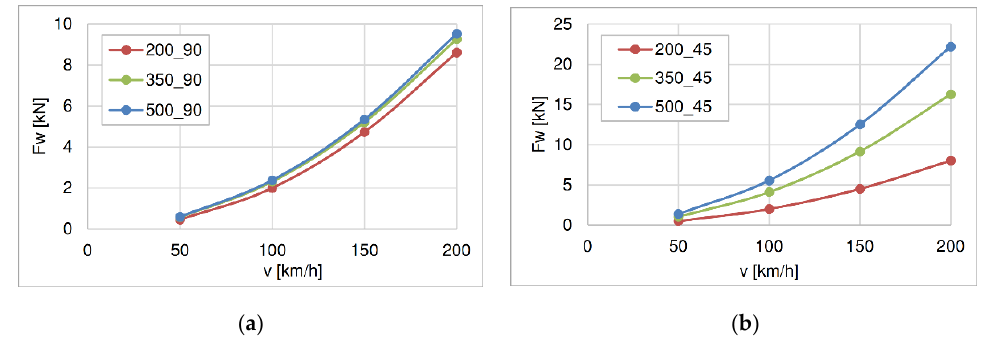
Figure 5. Average wind load depending on finned tubes distribution pitch for wind direction: ( a )  = 90  , ( b )  = 45  . ( a ) α = 90 ◦ , ( b ) α = 45 ◦